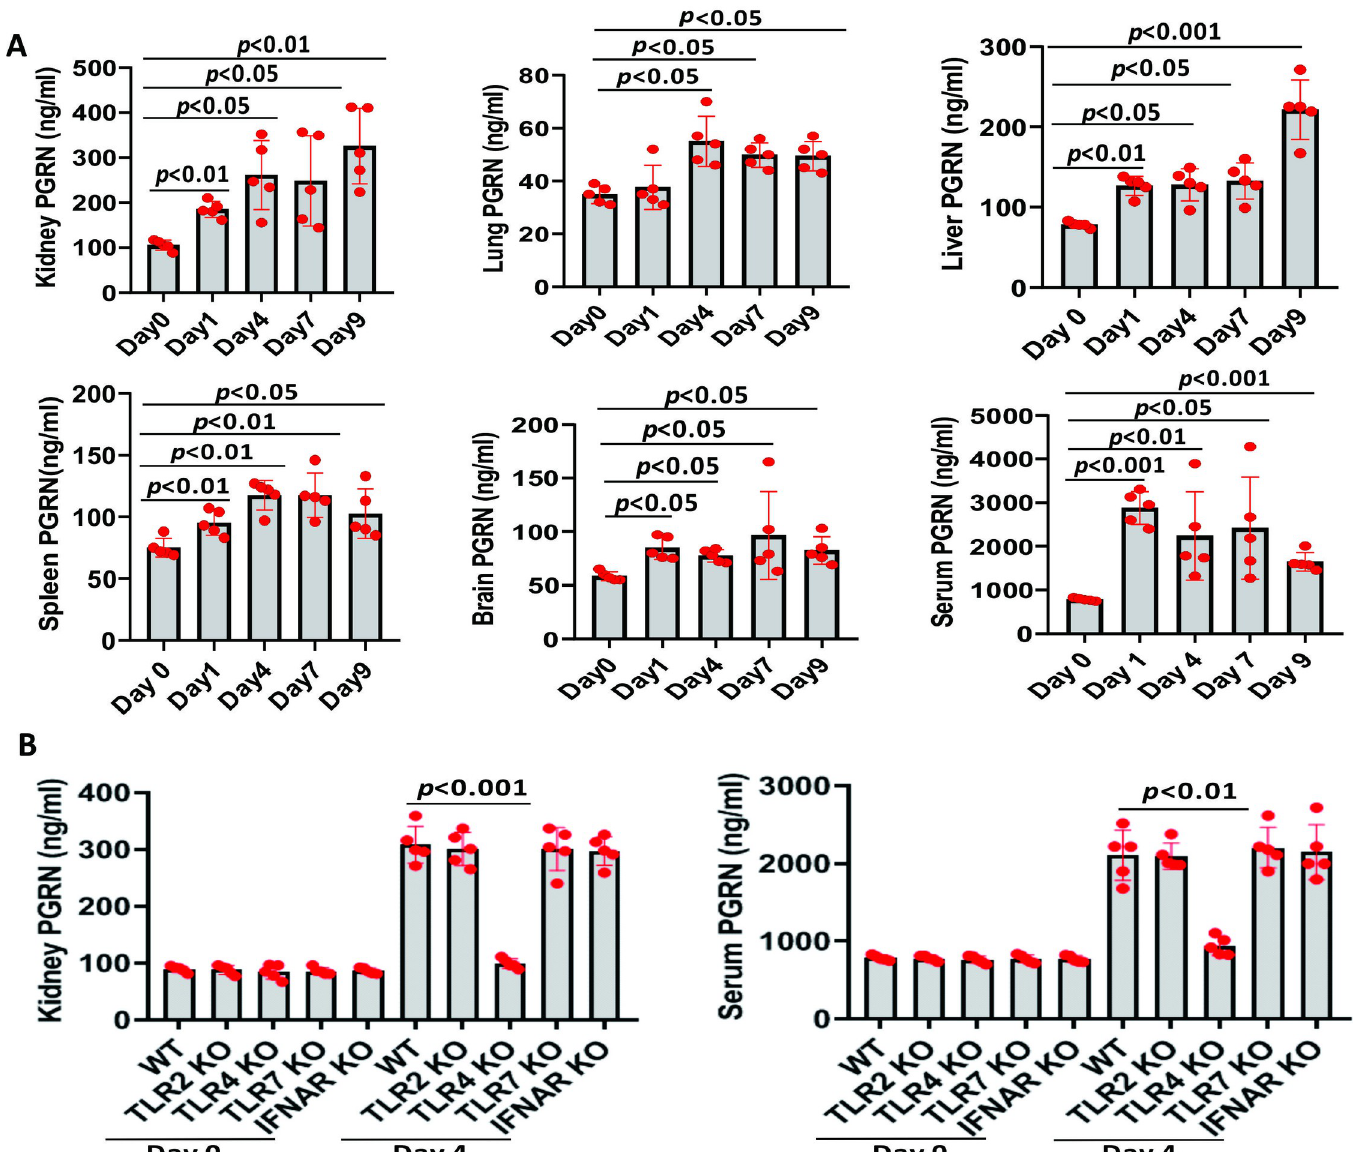
Fig 1. Local and systemic PGRN production in mice after invasive C . albicans infection. Wild type (WT, n = 5) mice were infected intravenously with 4 × 10 5 colony forming units (CFU) of C . albicans . (A) Organs were removed at the indicated time points, and blood was collected by cardiac puncture. Samples were assayed for PGRN content by specific sandwich enzyme-linked immunosorbent assay (ELISA). (B) PGRN concentrations in the kidney and blood from Toll-like receptor (TLR) 2 knockout (KO), TLR4 KO, TLR7 KO, type I IFN- α / β receptor (IFNAR) KO, and WT mice at the indicated times after intravenous infection with 4 x10 5 CFU of C . albicans . All data were pooled from three independent experiments. The statistical differences were determined by Kruskal-Wallis test followed by Dunn’s multiple comparisons post test, and p values were shown when compared between groups denoted by horizontal lines.